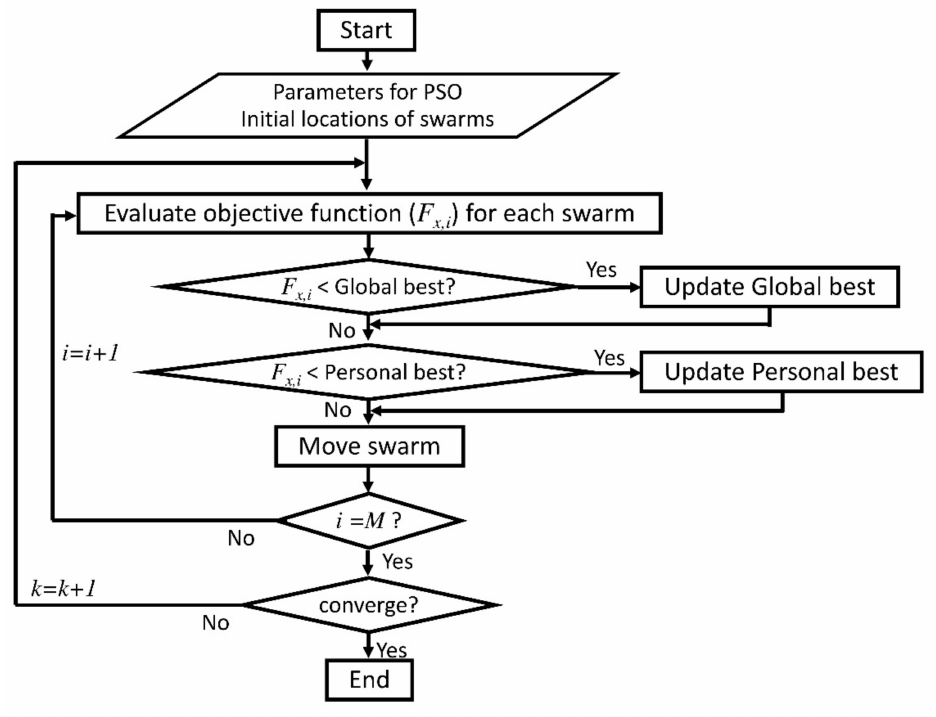
Figure 3. Flow chart of the calculation procedure in the PSO